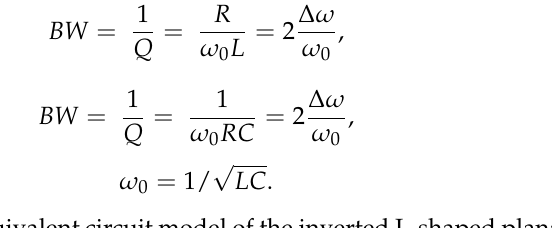
Figure 5. The equivalent circuit model of an inverted L-shaped planar monopole antenna on a partial ground plane in vacuum and with FR-4 substrate.